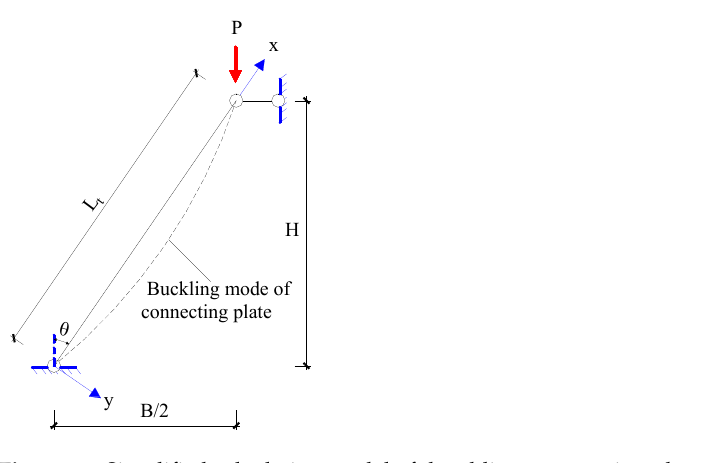
Figure 10. Simplified calculation model of the oblique connecting plate.